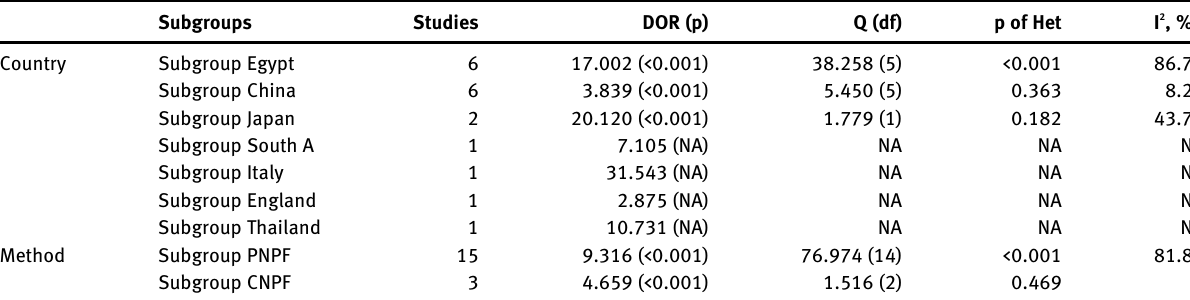
Table  : Results of subgroup meta-analysis based on DOR.